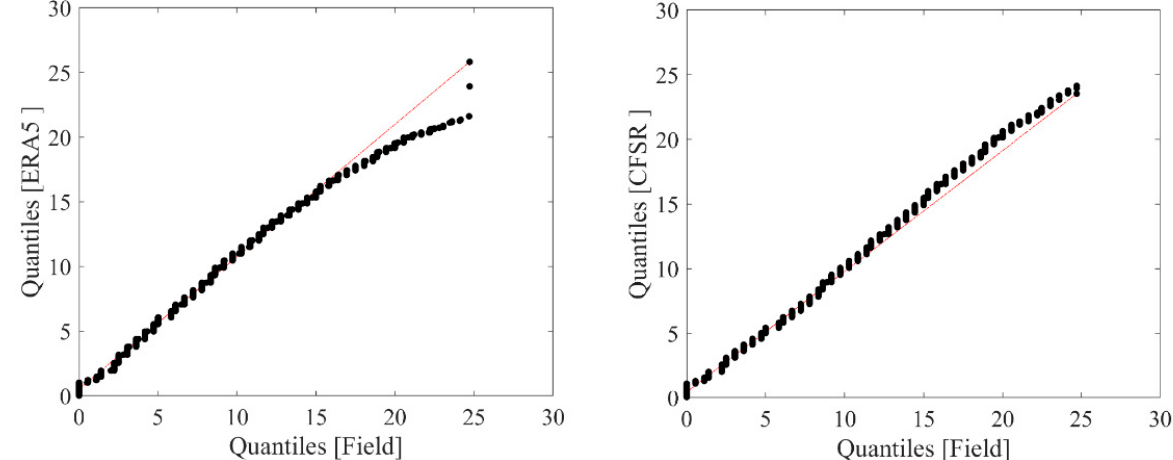
Figure 5. Q-Q plots showing the relationship between ERA5 and measured mean wind speed ( left ) and CFSR and measured mean wind speed ( right ) at the South Channel Station for over 15-year period (1998–2013). The CFSR and ERA5 data were interpolated into the coordinate of the coordinate of the South Channel Station.